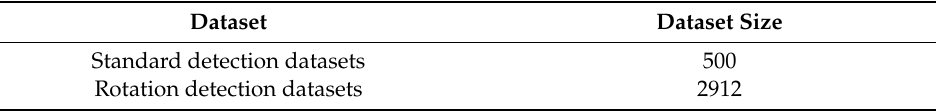
Table 2. Size of single-fish-labeled datasets after